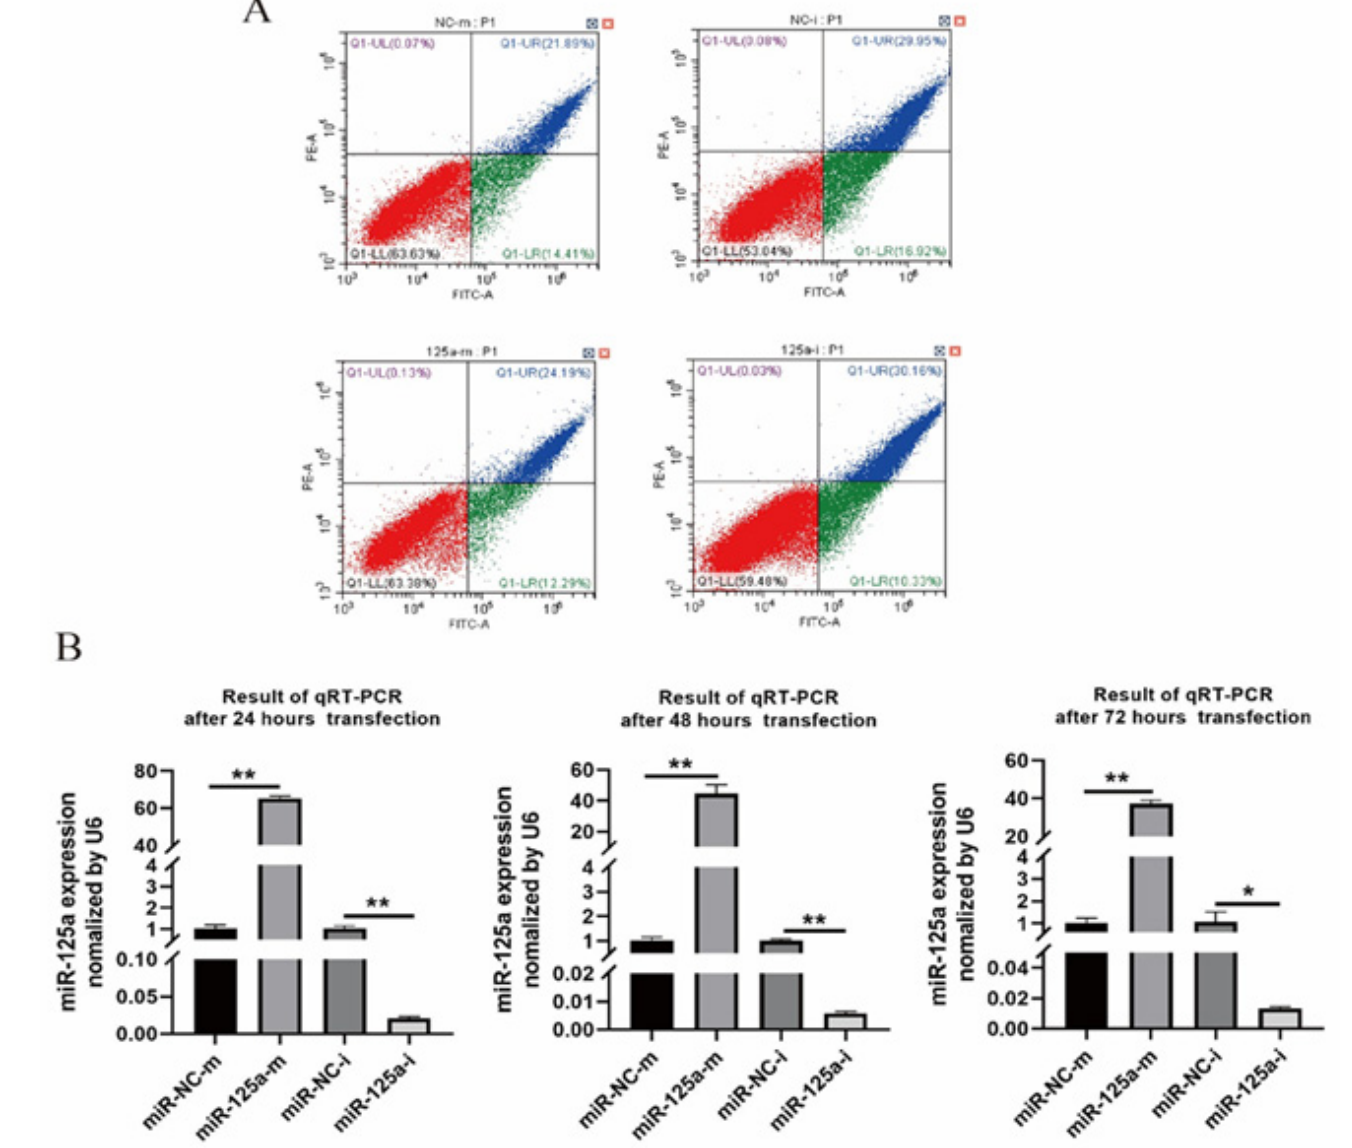
Figure 3. ( A ) After transfection with miR-125a mimic and inhibitor for 72 h, flow cytometry was used to detect the apoptosis rate of MAC-T cells; ( B ) Results of qRT-PCR. The expression levels of miRNAs at 24, 48 and 72 h after transfection. * Significant difference between the control and the treatment ( p < 0.05); ** Very significant difference between the control and the treatment ( p < 0.01). In addition, transfection with the miR-125a mimic significantly down-regulated the expression of the SAA1 gene, compared with that in the NC group ( p < 0.01); by contrast, transfection with miR-125a inhibitors significantly elevated the expression of the SAA1 gene, compared with that in the NC-i group ( p < 0.01); Figure 4A,B). The results of Western blotting showed that, compared with that in the negative- control group (miR-NC-m), the protein expression of SAA1 decreased gradually in MAC- T cells transfected with the miR-125a mimic at 48 and 72 h post-transfection, while MAC- T cells transfected with miR-125a inhibitors showed higher levels of the SAA1 protein than cells in the NC-i group at 48 and 72 h post-transfection (Figure 4C).